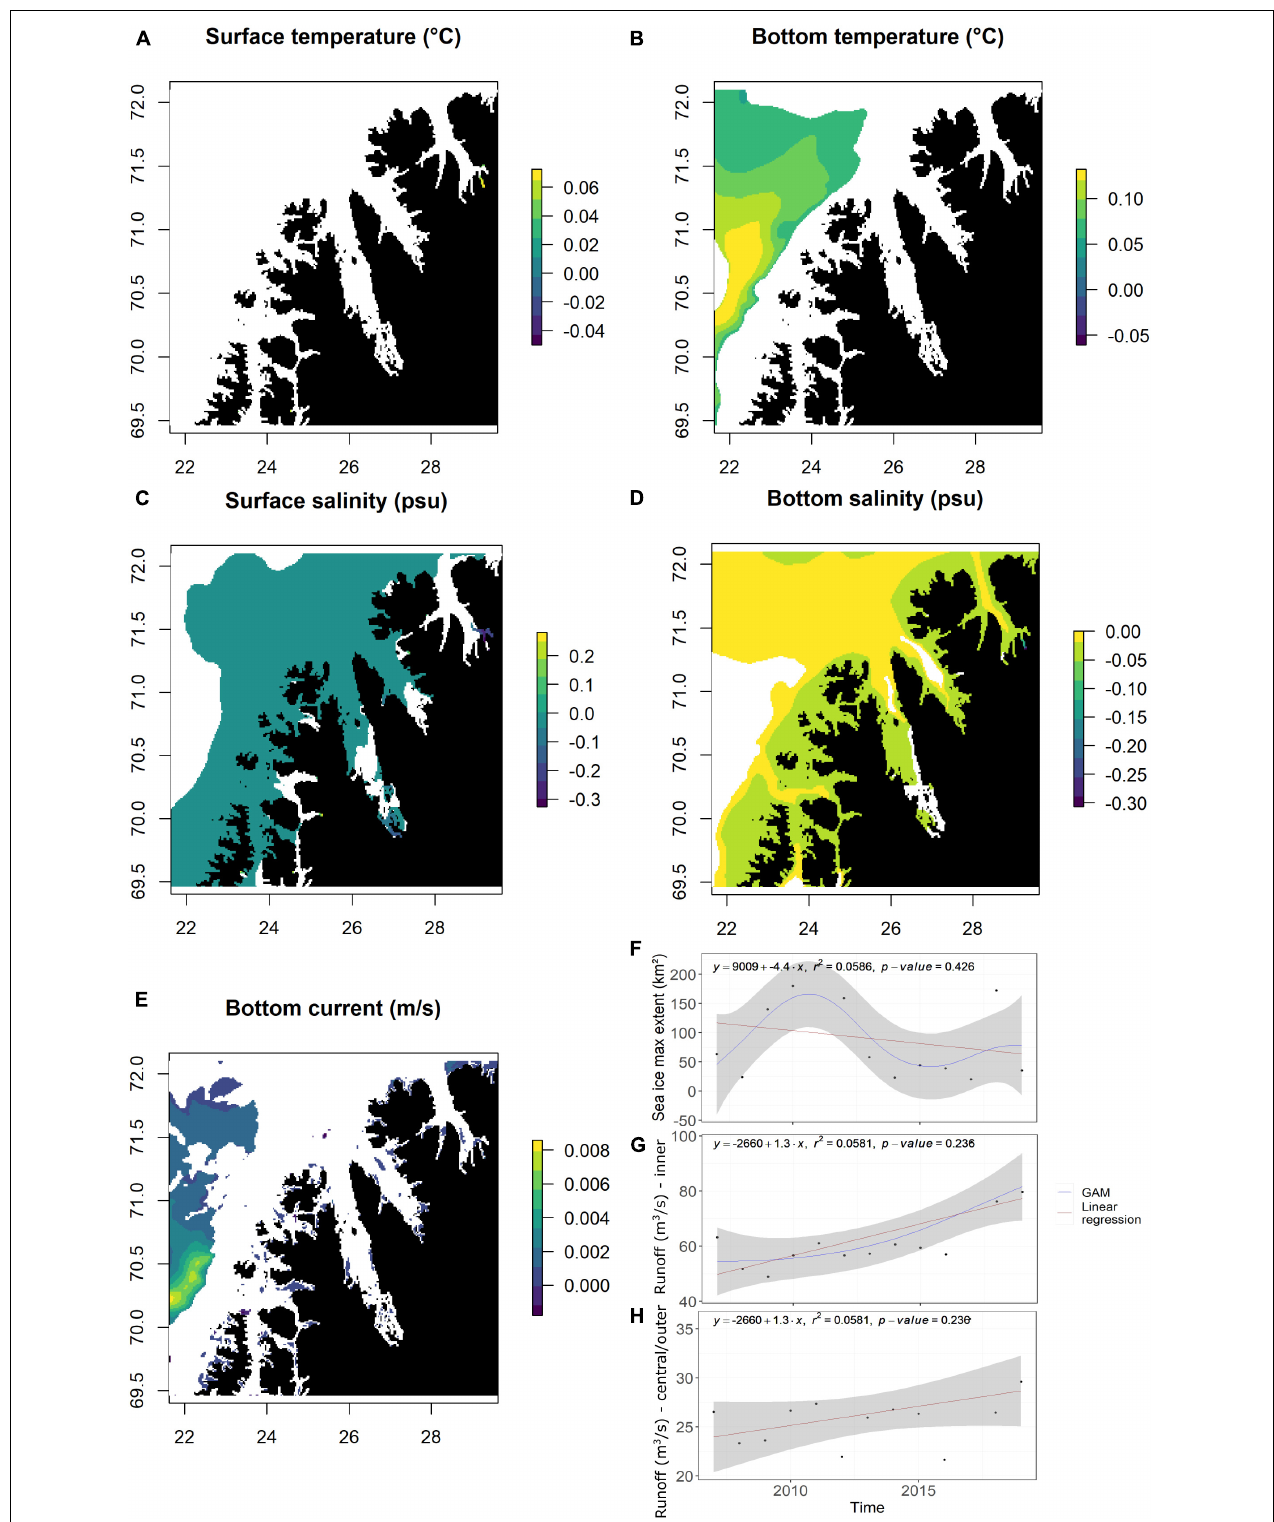
FIGURE 1 | Temporal trends of the environmental variables. For spatialized data (A–E) , linear regression was computed in each 800 × 800 m cell, only slopes with p -values < 0.1 are printed. For non-spatialized data (F–H) , linear regression was performed on the annual mean (stratified biomass), for the inner fjord for sea ice extent (F) and separated between inner (G) and central/outer (H) areas for river runoff.